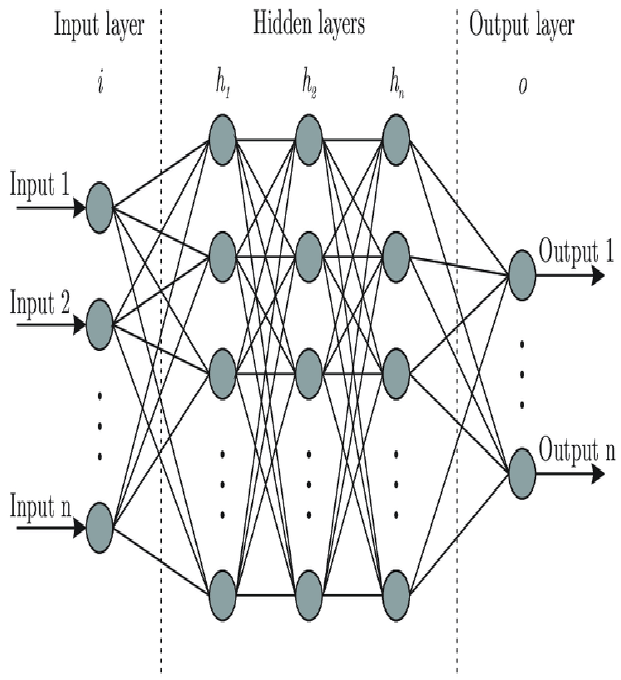
Figure 2: A typical architecture of the artificial intelligence (AI) structure (Le and Juszczyk,